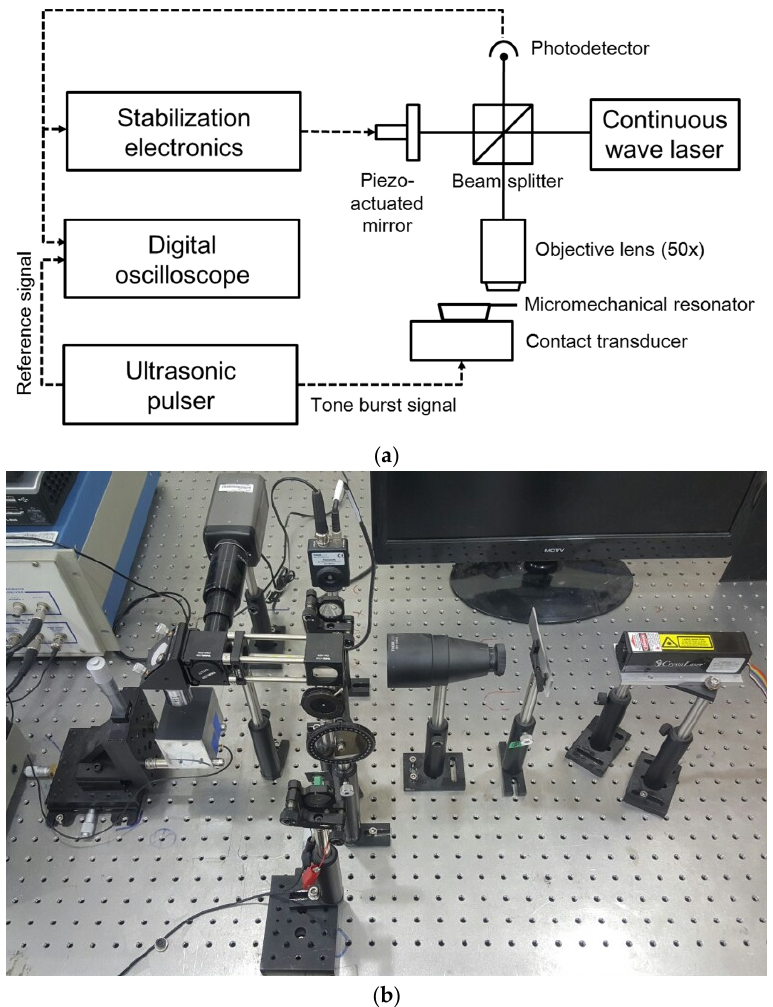
Figure 4. ( a ) A schematic representation of the experimental apparatus; ( b ) a picture of the actual interferometer setup.